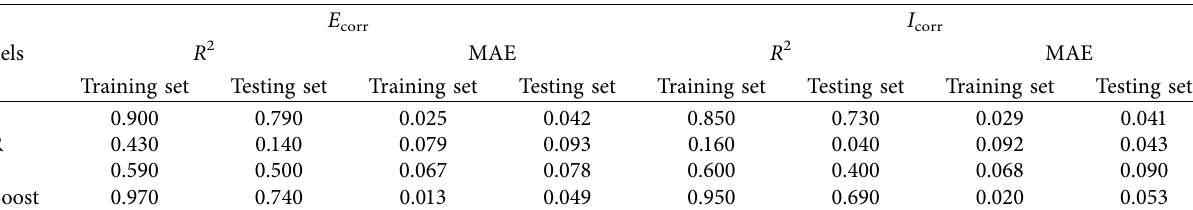
Table 4: Prediction accuracy of each algorithm (the R 2 and MAE calculation results for each optimized model in the training set and testing set).